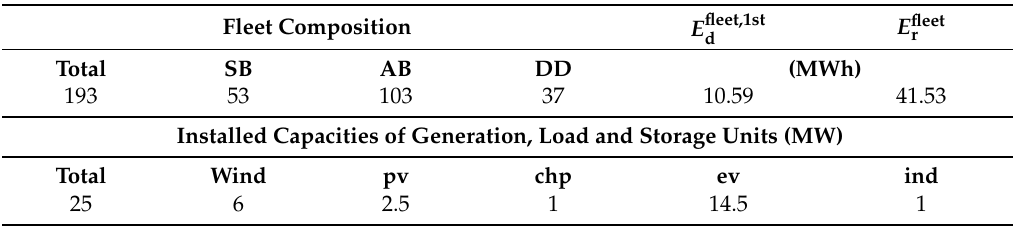
Table 2. Composition of the power plant portfolio and electric bus